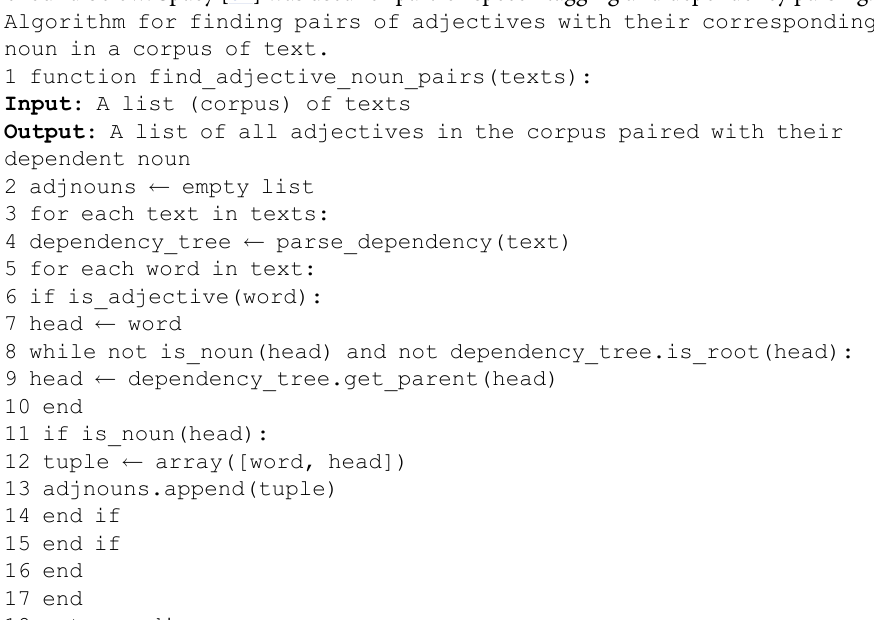
Algorithm for finding pairs of adjectives with their corresponding noun in a corpus of